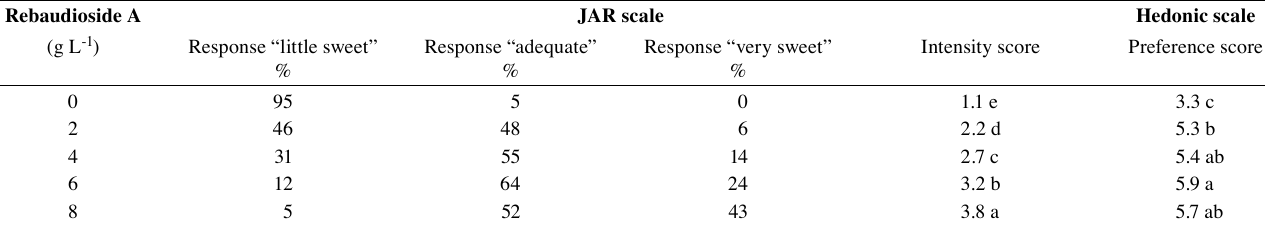
Values represent the mean ± standard deviation of 100 panelists. Different letters in the same column indicate statistically signifi cant difference by Tukey’s test (p < 0.05). Abbreviations: JAR = just about right.